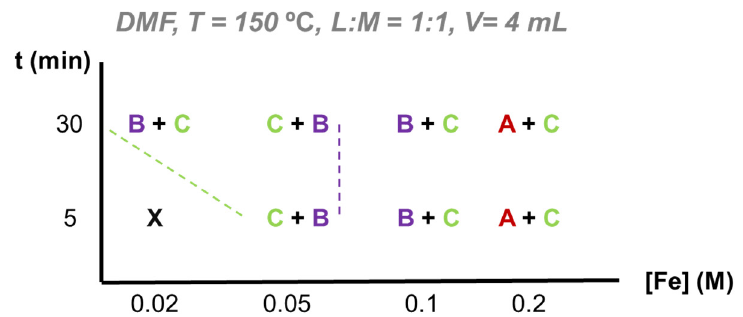
Figure 3. Crystallization diagram for the microwave-assisted solvothermal synthesis of the system FeCl 3 /H 2 BDC-NH 2 in DMF based on PXRD data. Legend: A = to MIL-53-NH 2 , B = to MIL-88B-NH 2 , C = to MIL-101-NH 2 , X = amorphous.